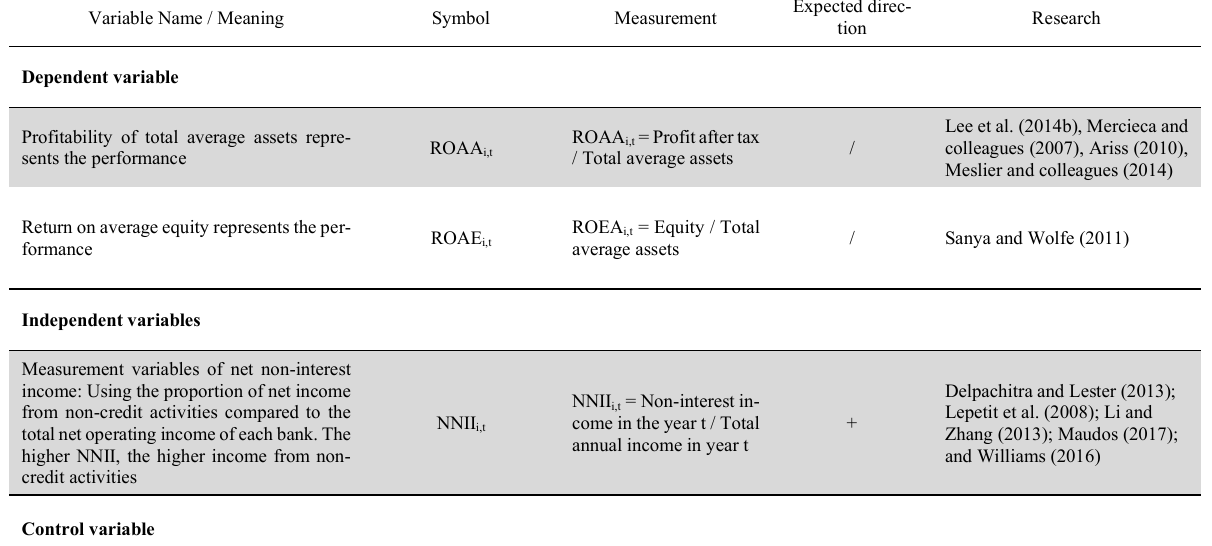
Detailed description of variables in the regression